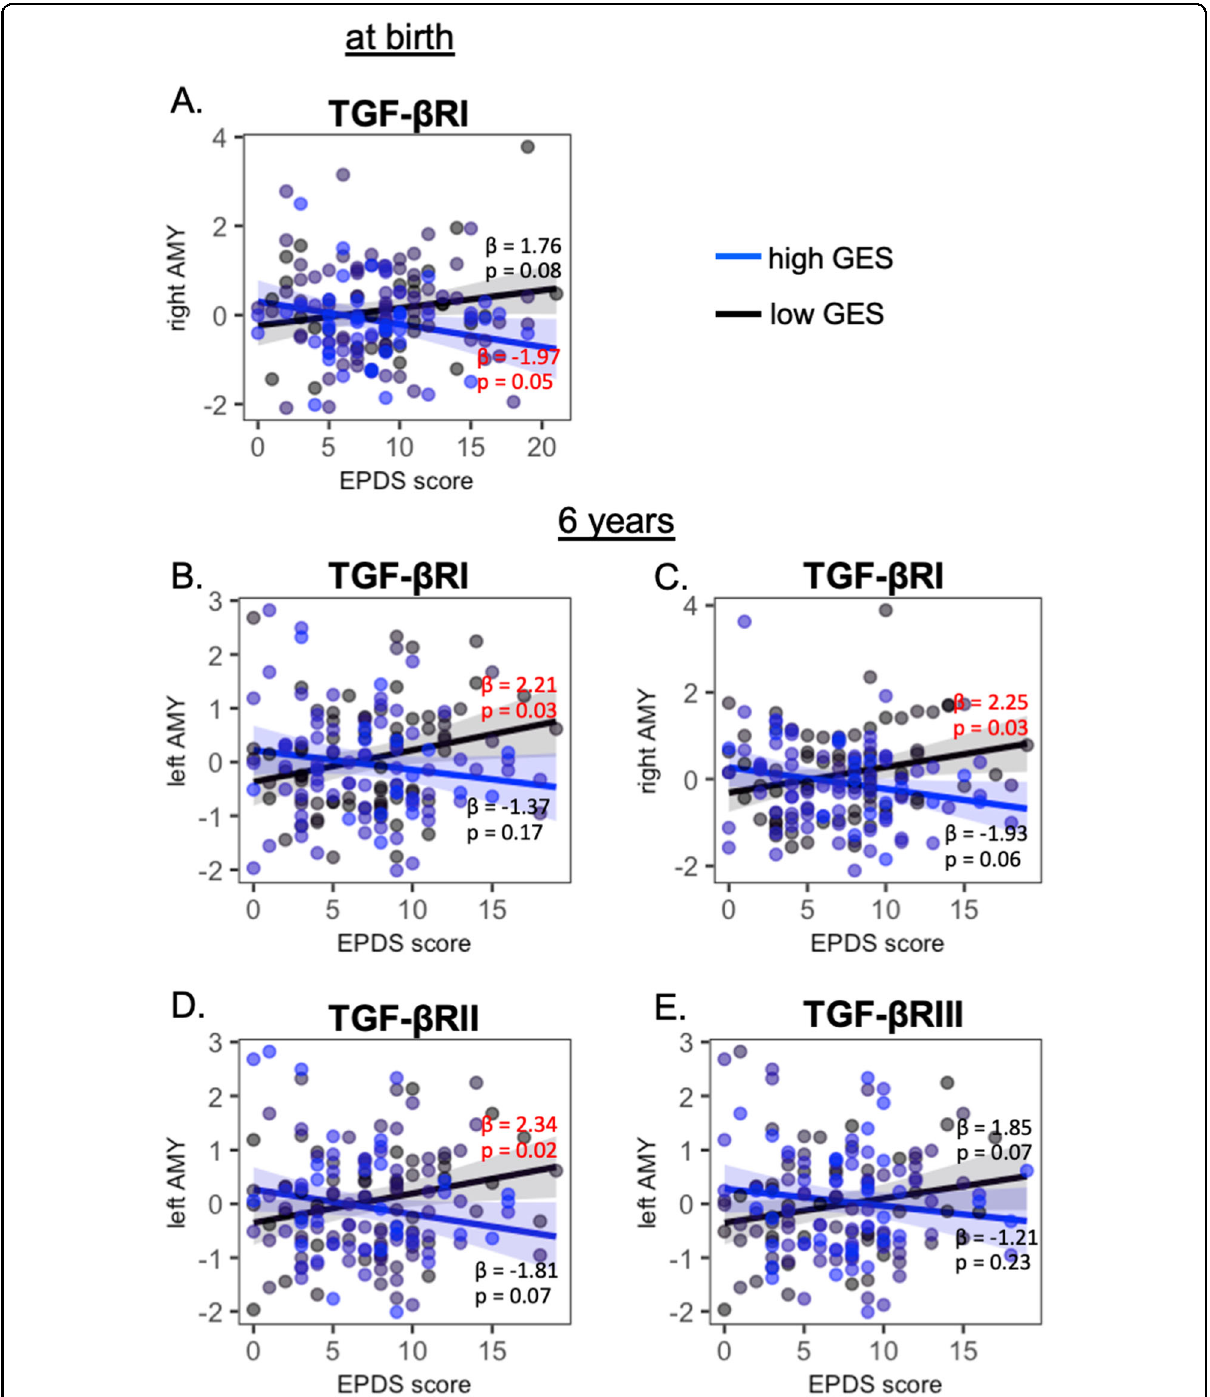
Fig. 3 Interaction of prenatal maternal depression and TGF- β receptors on amygdala volumes. Post hoc analysis of the interaction between prenatal maternal depression and the genetic variants of TGF- β RI, TGF- β RII, and TGF- β RIII on the amygdala volume at birth ( A ) and at the age of 6 years ( B – E ). The black and blue lines/dots represent the groups with low and high genetic expression scores (GES), respectively. β and p values in red indicate statistical signi fi